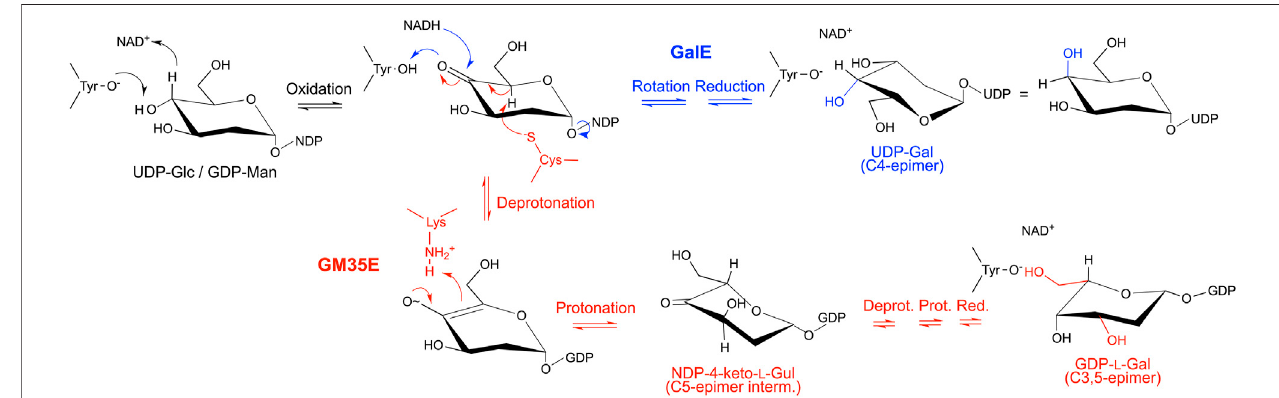
FIGURE 4 | Mechanistic similarities demonstrate the evolutionary connection between GalE and GM35E. The mechanisms of both enzymes start with the formation of a keto-group at C4 (black), followed by a rotation and reduction of the keto-intermediate in GalE (blue), whereas an additional catalytic acid and base promotedeprotonation/reprotonationatC5andC3intheGM35E(red)before fi nalreductionoftheketo-groupatC4.ThehydroxylgroupattheC2positionisnotshown for clarity reasons.